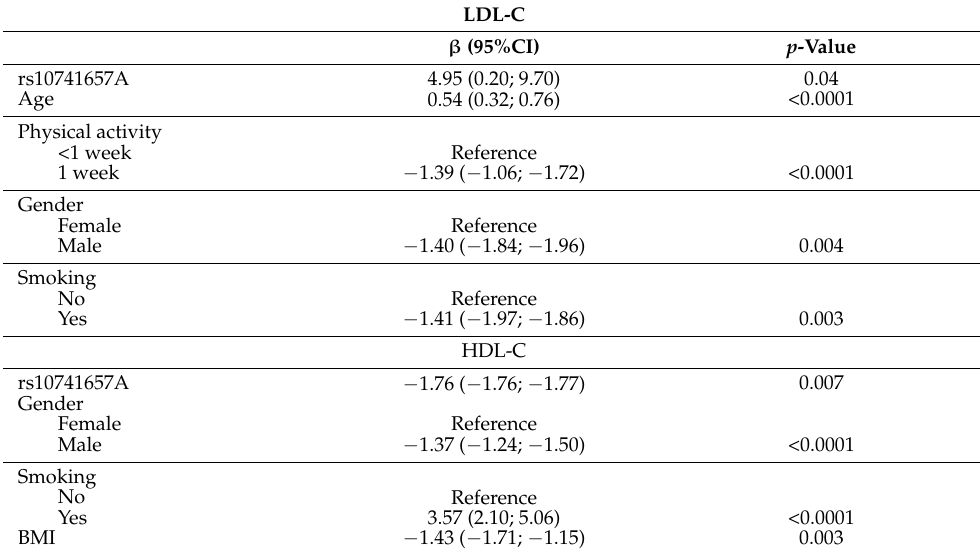
Table 2. Multivariate linear regression analysis with low- and high-density lipoproteins cholesterol.